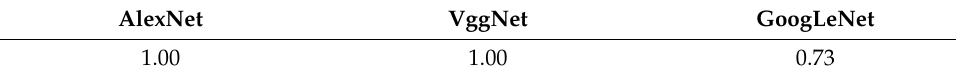
Table 9. AUC comparison when target is without glasses.